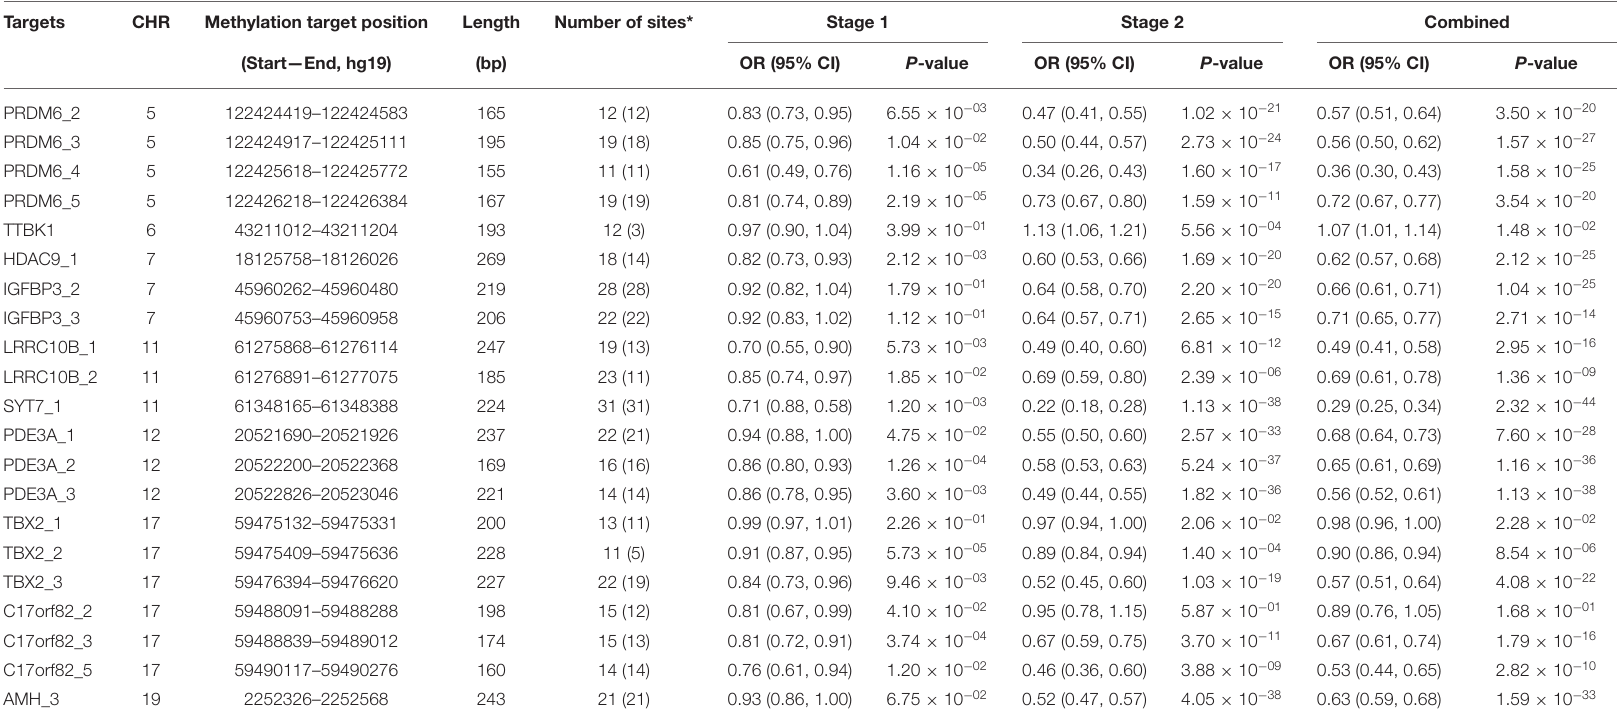
TABLE 2 | The associations between methylation levels of each target and ischemic